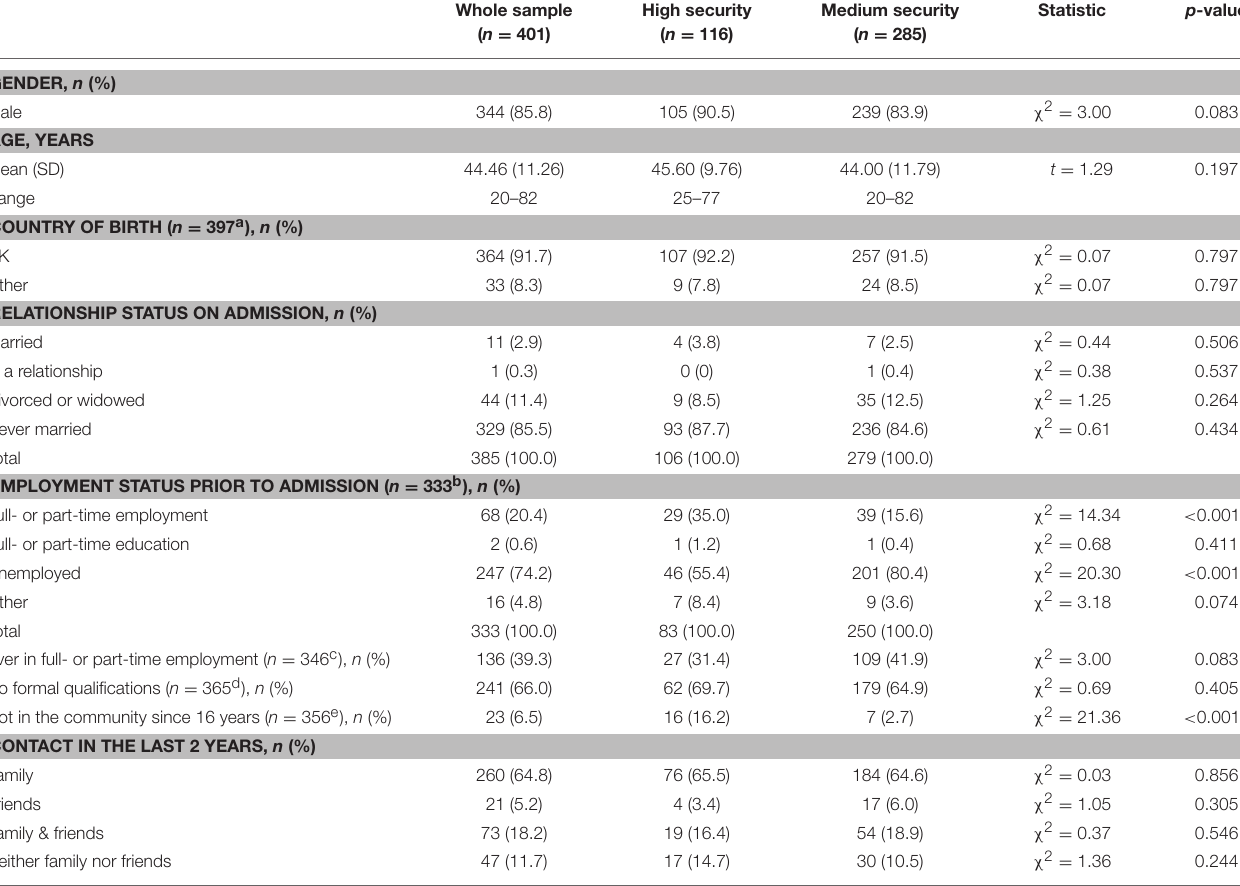
TABLE 1 | Sociodemographics of long-stay forensic